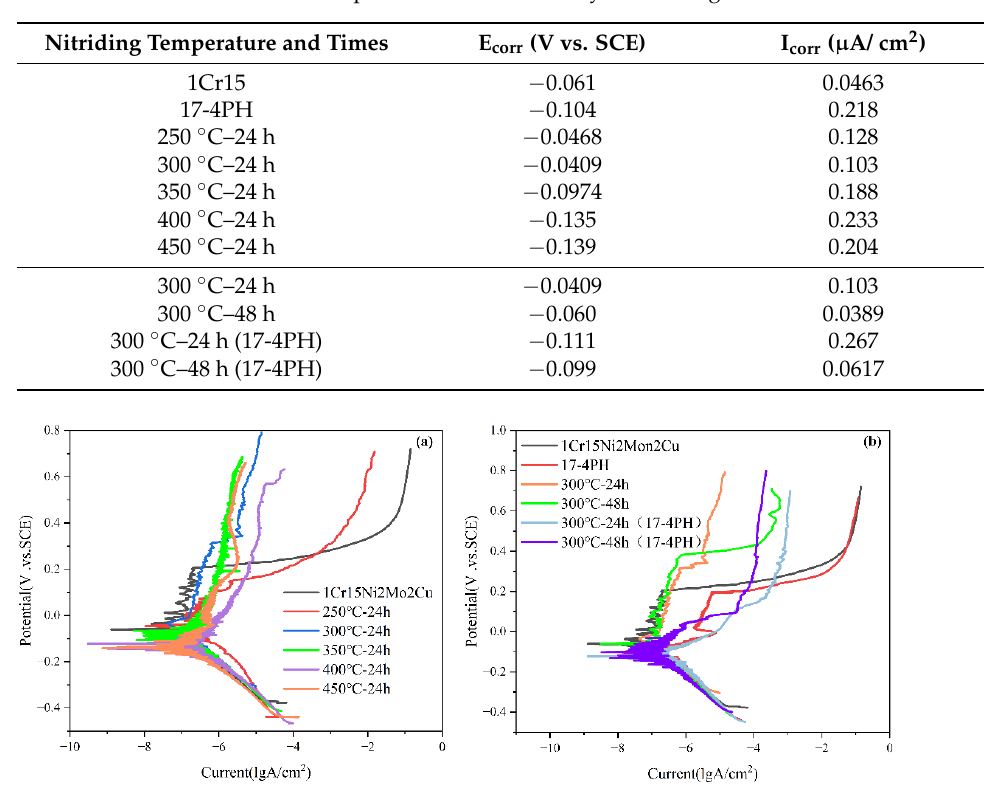
Figure 11. Electrochemical polarization curves of ( a ) 1Cr15 stainless steel at different nitriding temperatures and ( b ) 1Cr15 and 17-4PH stainless steel at different nitriding times in 3.5% NaCl solution. Table 6. Relevant electrochemical parameters calculated by Tafel fitting. Nitriding Temperature and Times